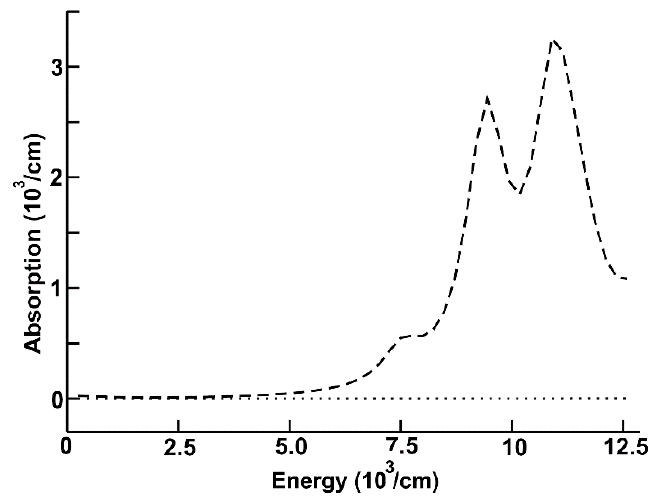
Figure 2. Optical absorption for the system cluster of lithium niobate adsorbed on the graphene layer (dashed curve) for the infrared region. Optical absorption of graphene (dotted line).